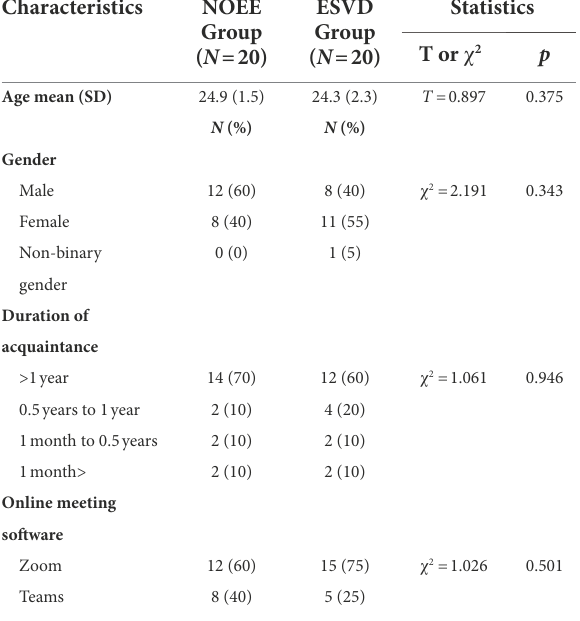
TABLE 1 Participant